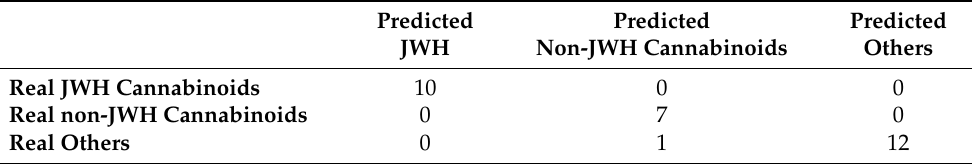
Table 2. Confusion matrix for the analyzed ANN—version 1: 29 (96.7%) tested compounds were correctly classified and 1 (3.3%) was misclassified.